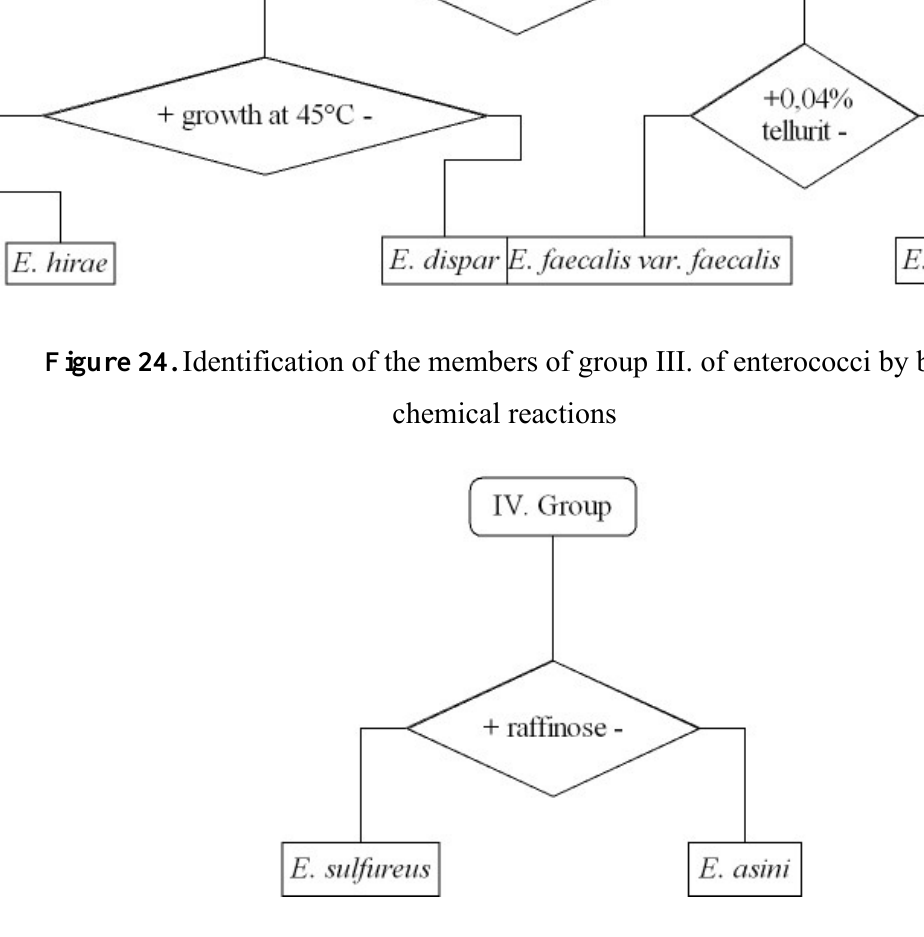
Figure 24. Identification of the members of group IV. of enterococci by biochemical reactions